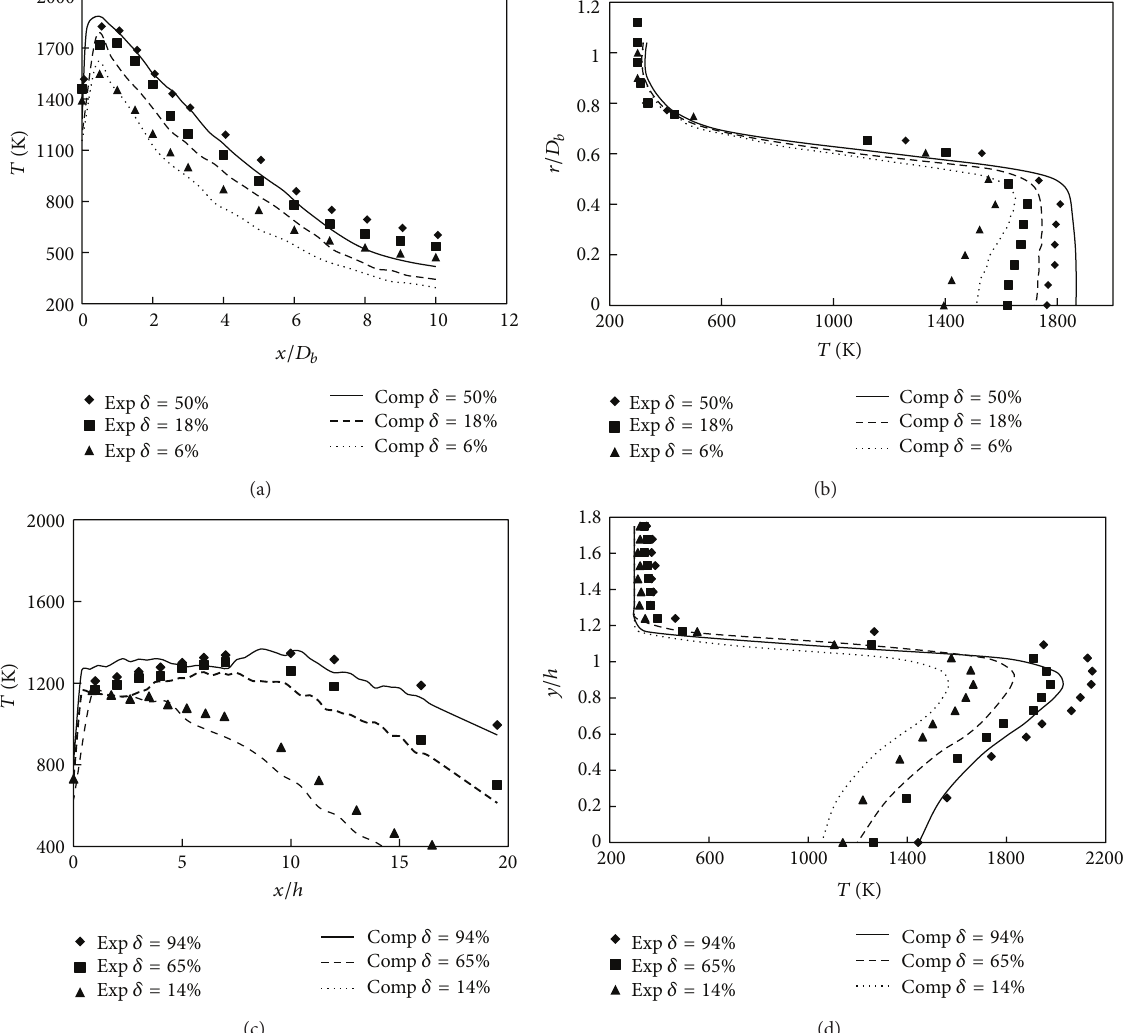
Figure 6: Comparisons between simulated and measured time-mean streamwise and cross-stream temperature distributions for disk ((a), (b)) and square ((c), (d)) burners, respectively. Cross-stream temperature distributions were taken at 𝑥/𝐷 𝑏 = 0.4 for the disk and at 𝑥/ℎ = 0.6 for the